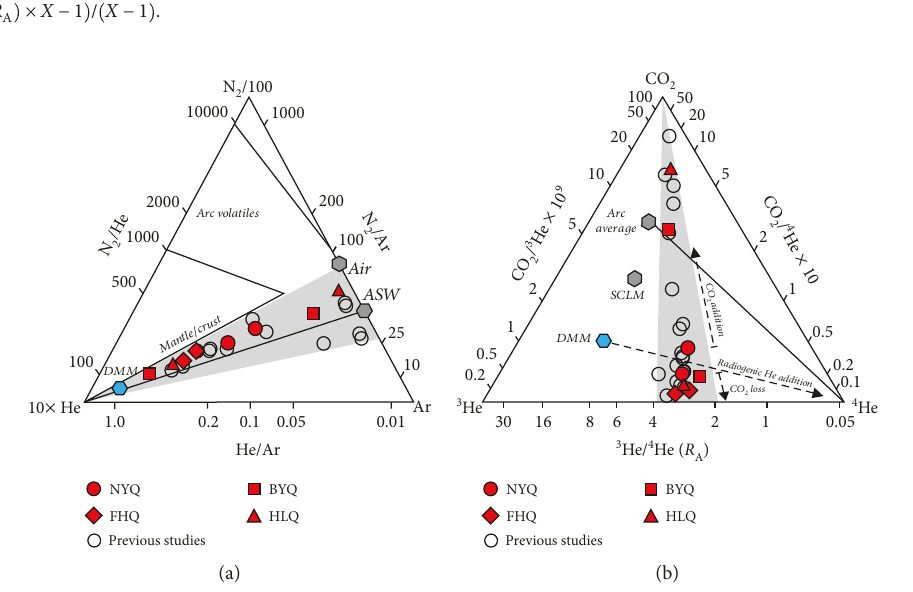
Figure 5: Triangle plot of N -He-Ar (a) and CO - 3 He- 4 He (b) for the cold spring gases in WMVF (modi fi ed from Giggenbach et al. [47]). 2 2 Filled and open symbols represent, respectively, data in this study and published data in [18 – 22, 48]. The compiled data in previous studies are available in Supplementary Table S3. Abbreviations: NYQ: South spring; BYQ: North spring; FHQ: Fanhua spring; HLQ: Hualin spring; ASW: air-saturated water; Arc average: arc-related volatiles ( 3 He/ 4 He = 5 4 ± 1 9 R A , [49]; CO 2 / 3 He = 4 5 ‐ 29 × 10 9 , [46]); SCLM: subcontinental lithospheric mantle ( 3 He/ 4 He = 6 1 ± 0 9 R A , [50]; CO 2 / 3 He = 4 × 10 9 , [51]); DMM: depleted MORB-source mantle ( 3 He/ 4 He = 8 ± 1 R A , [52]; CO 2 / 3 He = 1 5 × 10 9 ,